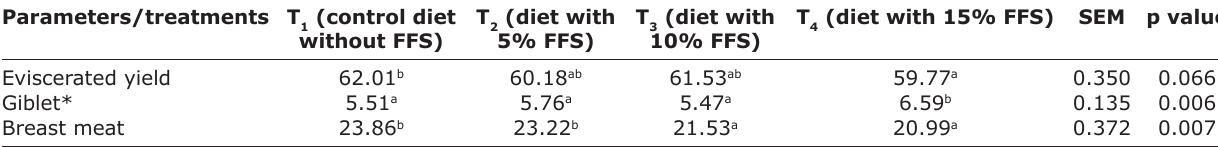
Table-3: Effect of feeding FFS on carcass yield of broiler Japanese quails at 5 weeks of age. Parameters/treatments T (control diet 1 without FFS)